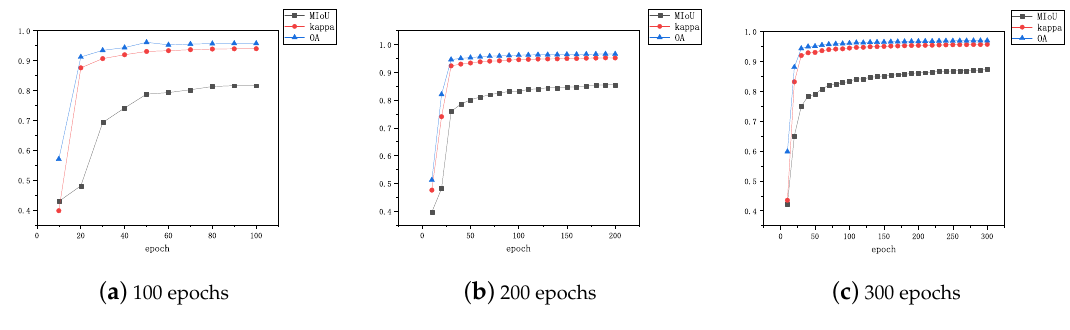
Figure 11. Training Epoch.